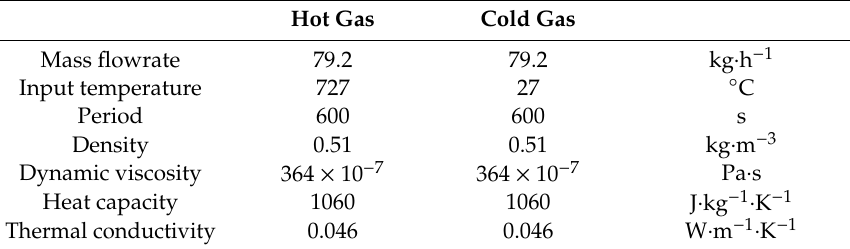
Table 4. Properties of hot and cold fluid.